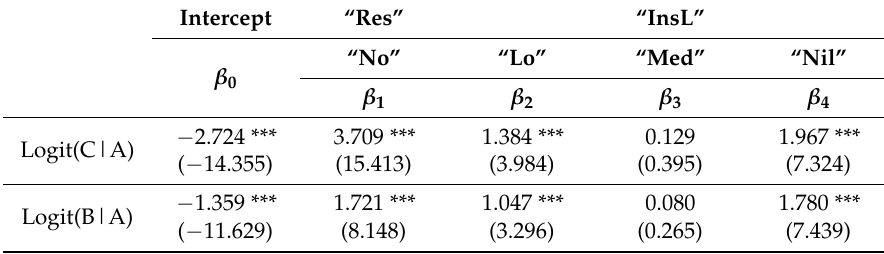
Table 4. Modelling probabilities of financial distress upon residency and insurance of patients.